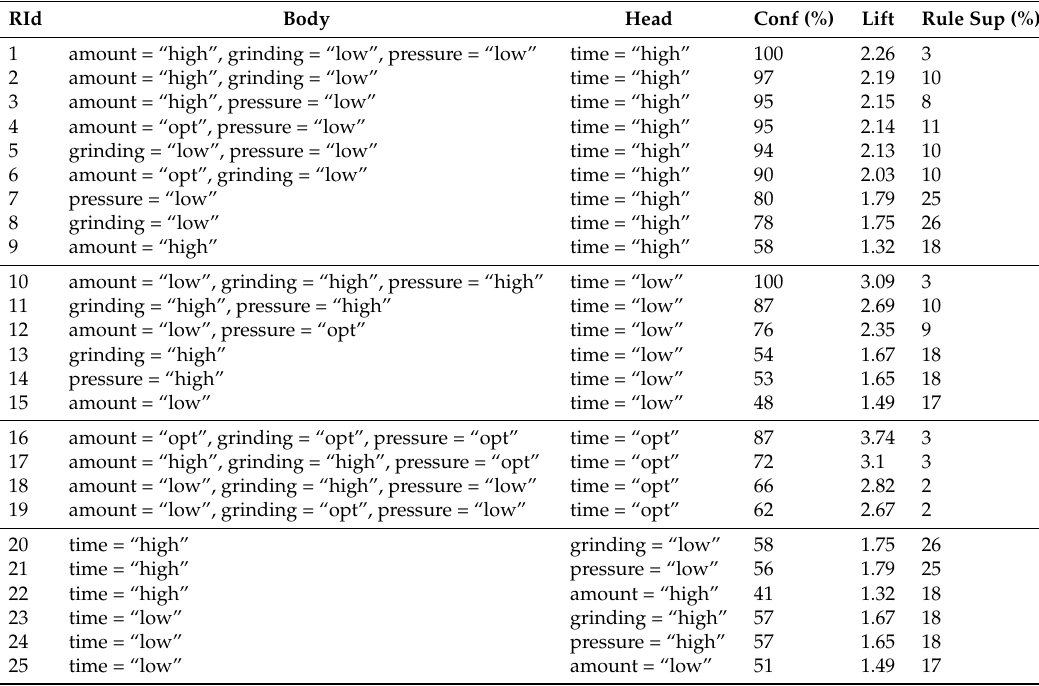
Table 6. Association rules involving the percolation time correlations.